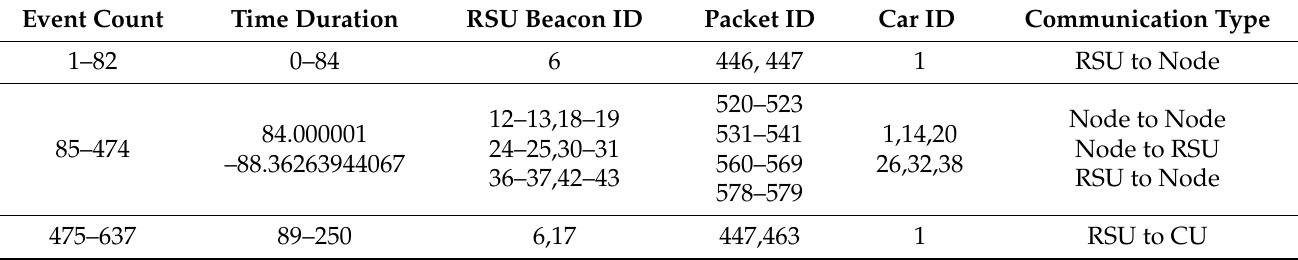
Table 4. Results of Markov based